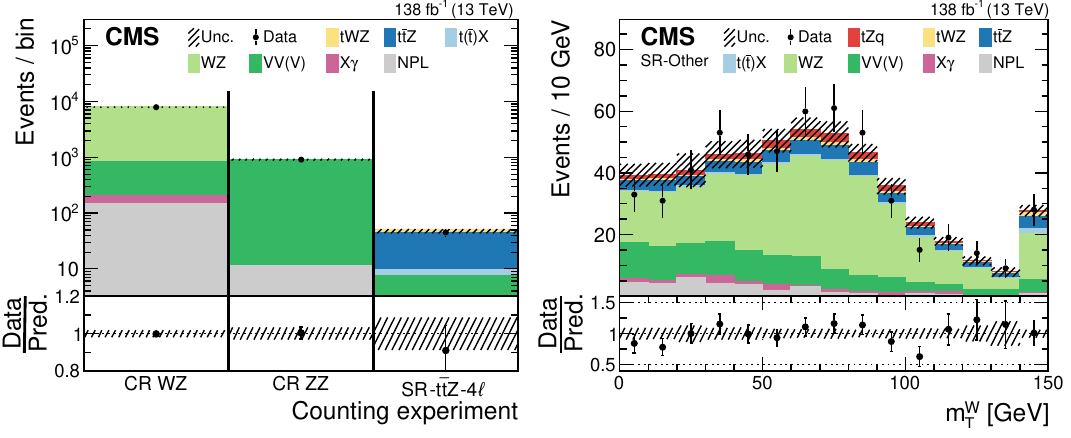
Figure 4 . Post-fit data-to-simulation comparisons for the distributions that are common to all fits, corresponding to counting experiments in the CRs and SR- ttZ - 4 ‘ (left), and to the m W in the SR-Others (right), after the 5D fit. The lower panels display the ratios of the observed event yields to their post-fit expected values. Overflows are included in the last bin of the right